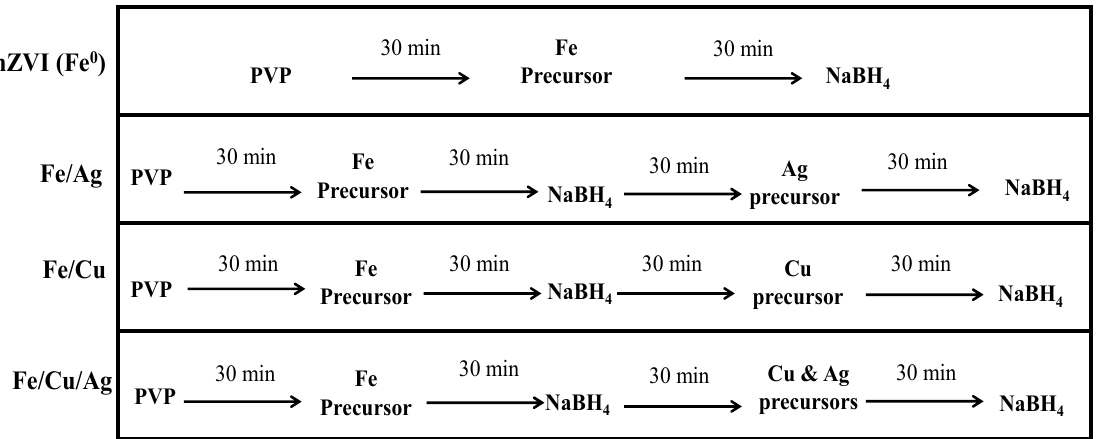
Figure 13. Summary of precursor addition sequence of the nanoparticle synthesis procedure.